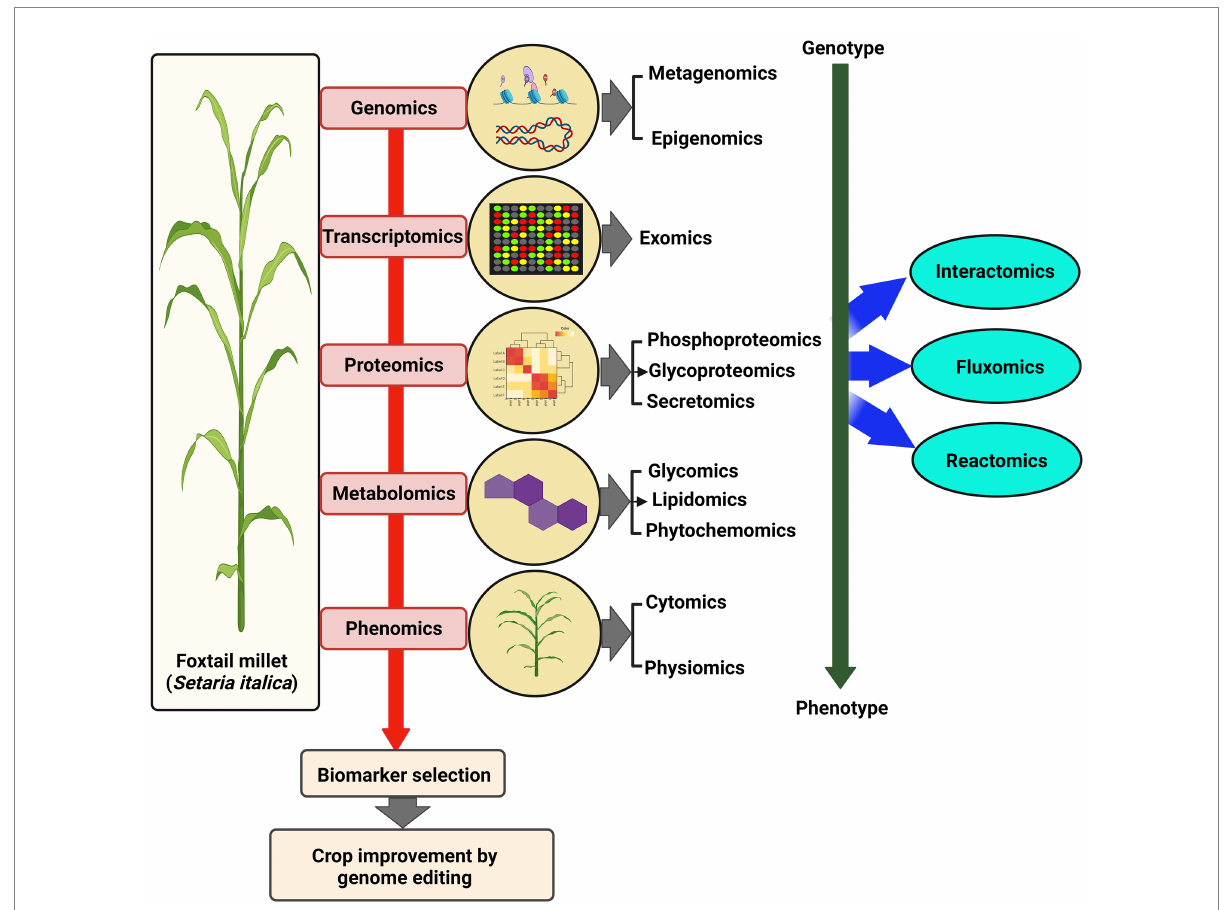
FIGURE 3 Multi-OMICS approach for crop improvement. Various advanced “OMICS” approaches used to understand different biological aspects in foxtail millet, from genotype to phenotype. These large-scale studies lead to the identification of biomarkers that paves the way for OMICS-assisted crop